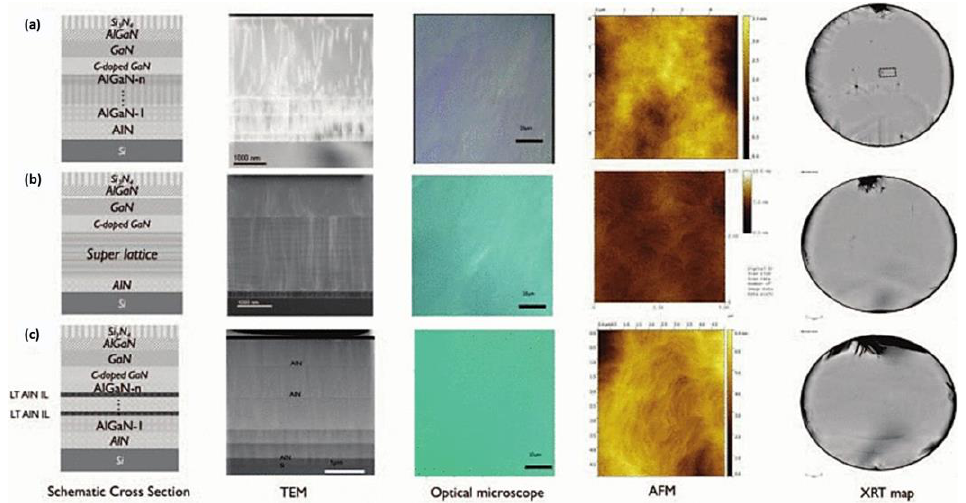
Figure 5. Schematic cross-section (not to scale), TEM, optical microscope, AFM, and X-ray topography map (XRT) of ( a ) stepped buffer, ( b ) superlattice, and ( c ) low-temperature AIN interlayer. Both the superlattice and interlayer approaches reduce the density of slip lines and cracks significantly with respect to the step-graded buffer approach [138]. Figure reproduced with permission from IEEE Proceedings.